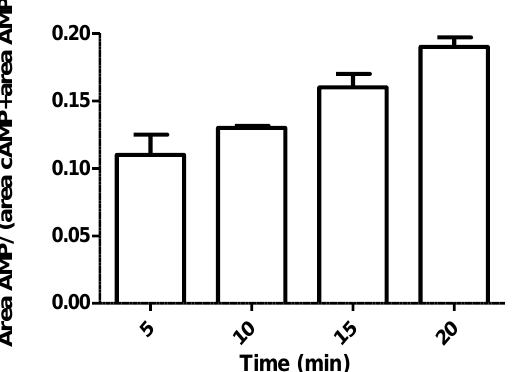
Figure 4. Enzymatic activity evaluated by the ratio of AMP area and AMP + cAMP areas after enzyme incubation at different time points (0, 5, 10, 15, 20 min after incubation) ( n = 3).